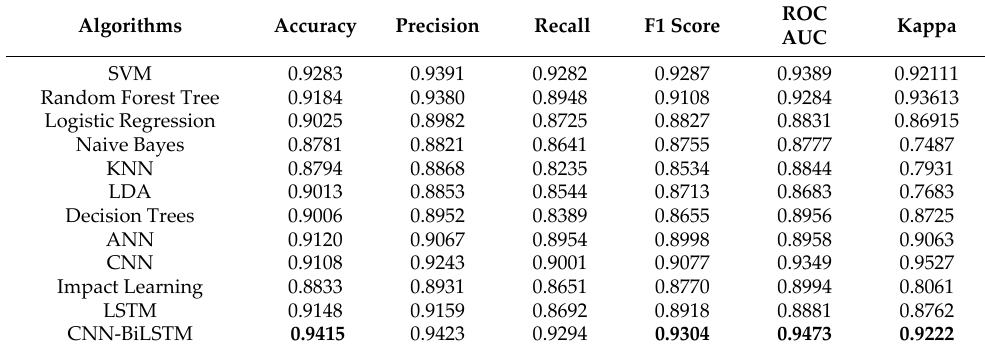
Table 6. Performance of Bangla-BERT.